Question: State the chart type depicted above.
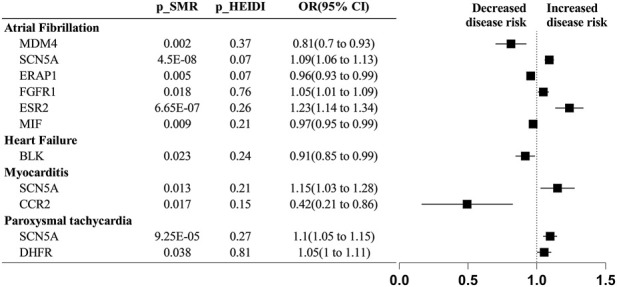
Answer: forest